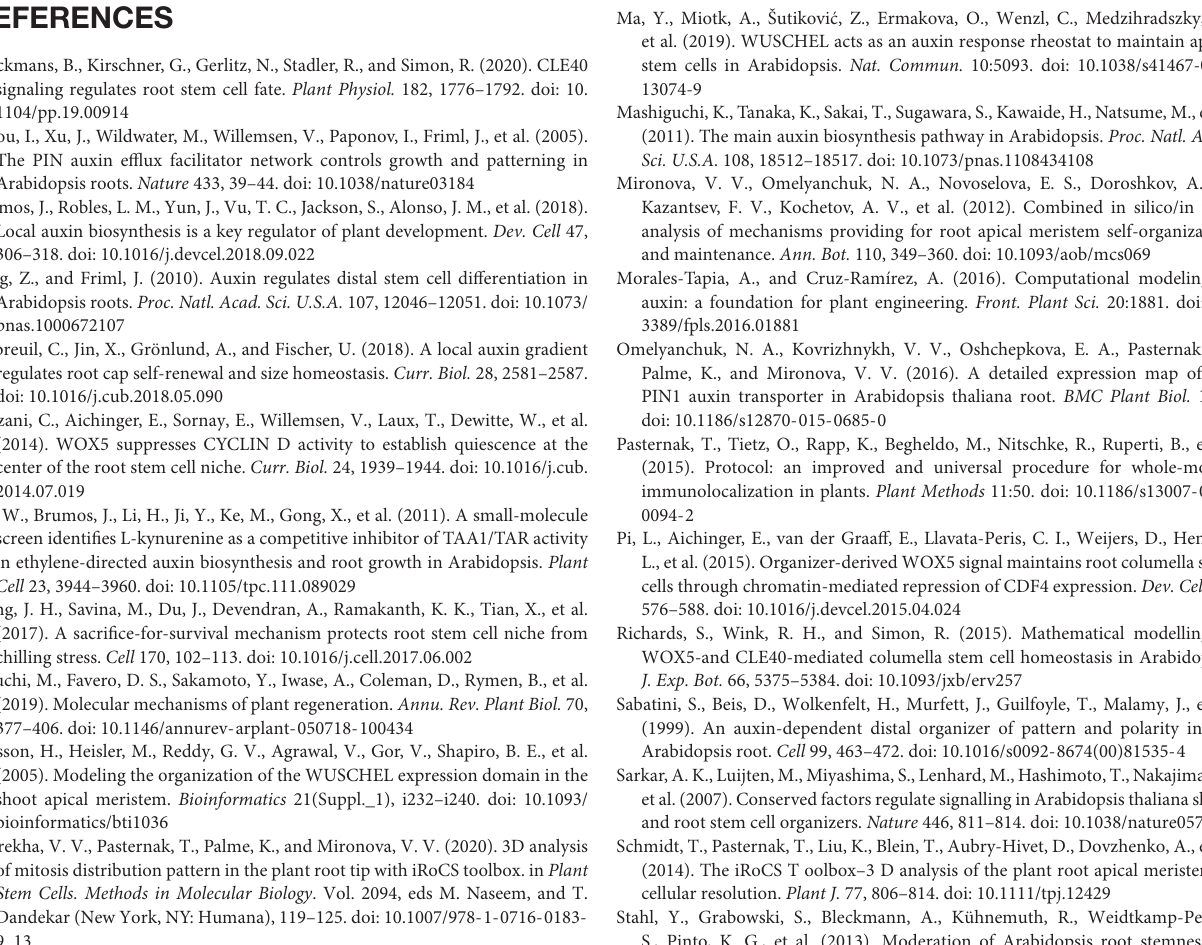
Supplementary Figure 3 | TAA1, PIN1, and PIN4 transcription is induced upon DEX treatment in 35S:WOX5-GR root tips. qRT-PCR analysis of TAA1 (A) , PIN1 (B) , PIN4 (C) expression in roots after 6 h, 24 h DEX, and after 24 h DEX + L -kynurenine exposure. Data represent fold changes in transcript levels compared those in mock-treated plants. Error bars show SD. Three biologically independent samples were analyzed per treatment and per time point. Statistical significance was done by Welch’s t -test ( ∗ p < 0.05; ∗∗ p < 0.01; ∗∗∗ p < 0.001). Supplementary Figure 4 | PIN2 expression domain did not change significantly in 35S:WOX5-GR root tips after 48 h of DEX exposure, except being additionally expressed in the extra layers of the lateral root cap. Immunolocalization for PIN2 at 0 and 48 h time points of DEX exposure. DAPI is in white. The QC location is marked by the red asterisks. Blue arrows mark lateral root cap layers with PIN2 expression under the QC position. The bar scale – 20 µ m. Supplementary Figure 5 | Knockout mutant wox5-1 compared to wild type. (A) Anatomy of wild type root tip. (B) DR5:GFP expression in wild type root tip. (C)